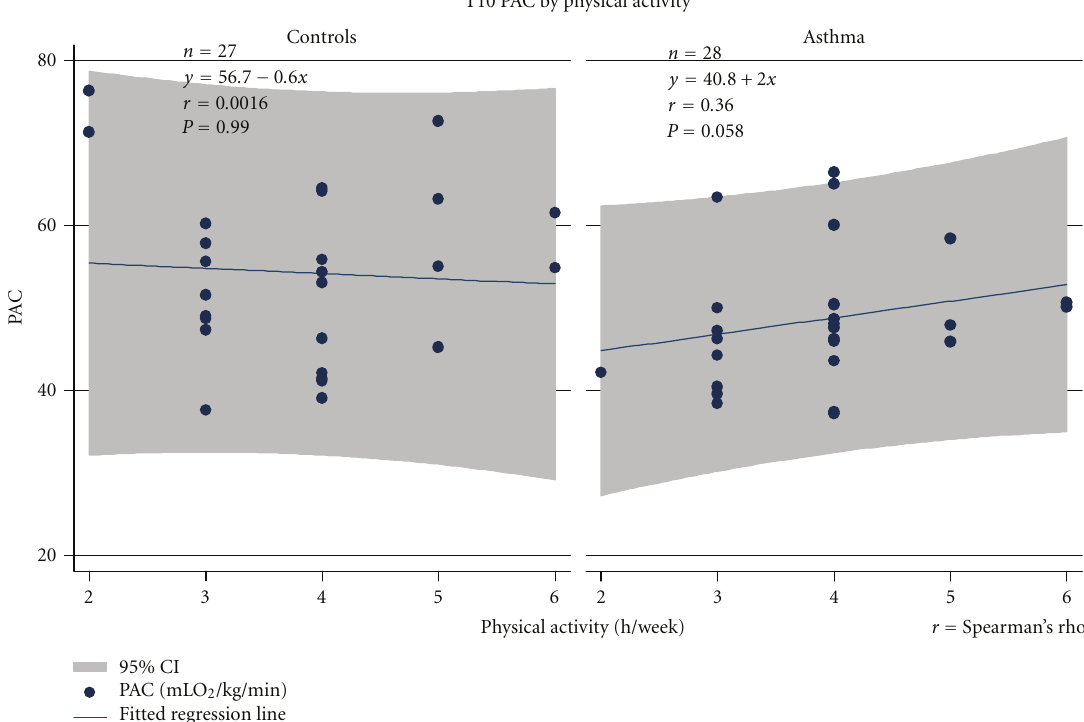
Figure 5: T10 associations between PAC (mLO 2 /min/kg) and physical activity (h/week) in asthmatics and